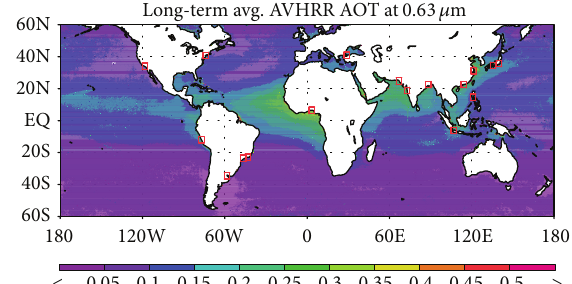
Figure 2: Global map of temporal averaged (1981–2009) monthly mean AOT along with the locations of seventeen MCCZ marked by red square